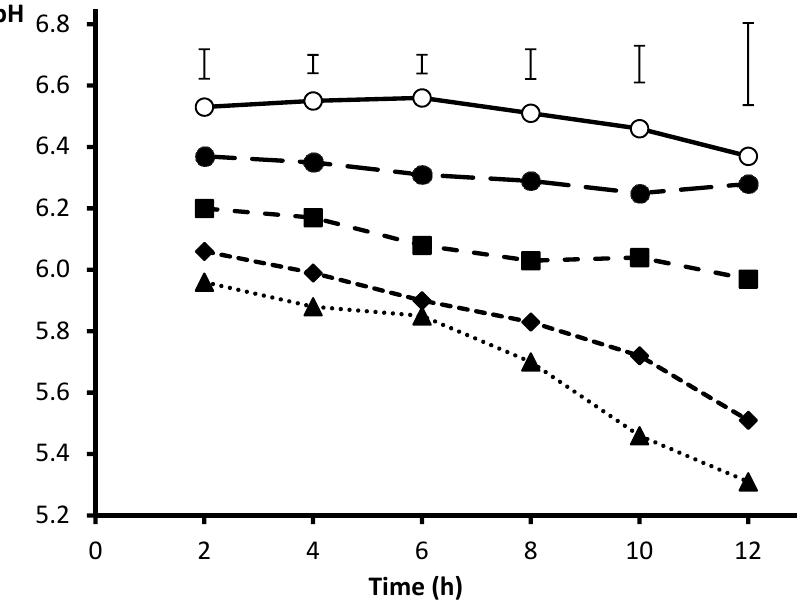
Figure 1. Pattern of incubation pH according to the concentration of bicarbonate ion in the medium for bu ff ering to 6.5 ( ), 6.25 ( • ), 6.00 ( (cid:4) ), 5.75 ( (cid:7) ) and 5.50 ( (cid:78) ). From Amanzougarene and Fondevila [40].